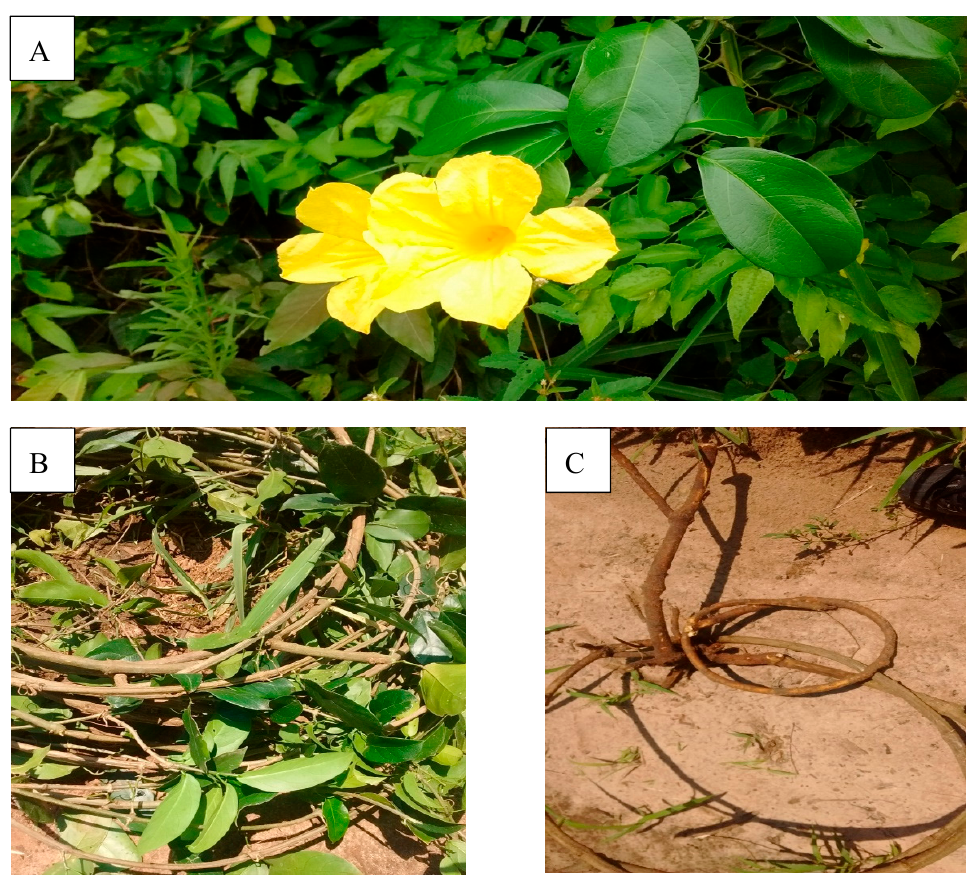
Figure 1. The Paraguayan crude drug “ysypó hû” ( Adenocalymma marginatum ). ( A ) flowering plant; ( B ) aerial parts; ( C ) root and stem.